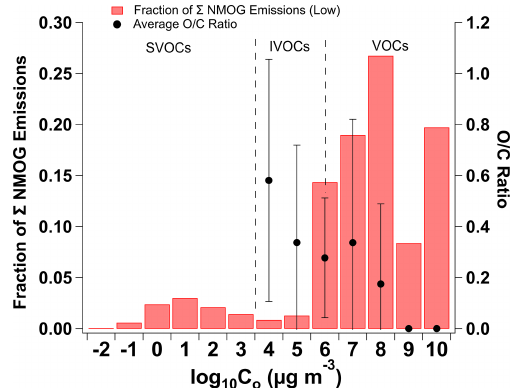
Figure 7. Fraction of total (cid:54) NMOG emissions in each volatility bin, and the bin-averaged O / C ratio spanning VOCs, IVOCs, and SVOCs. Data are included from PTRMS, CIMS, AWAS, and car- tridge measurements. The O / C ratio is derived for only the PTRMS, CIMS, and AWAS measurements, and the error bars indicate the standard deviation of the average O / C